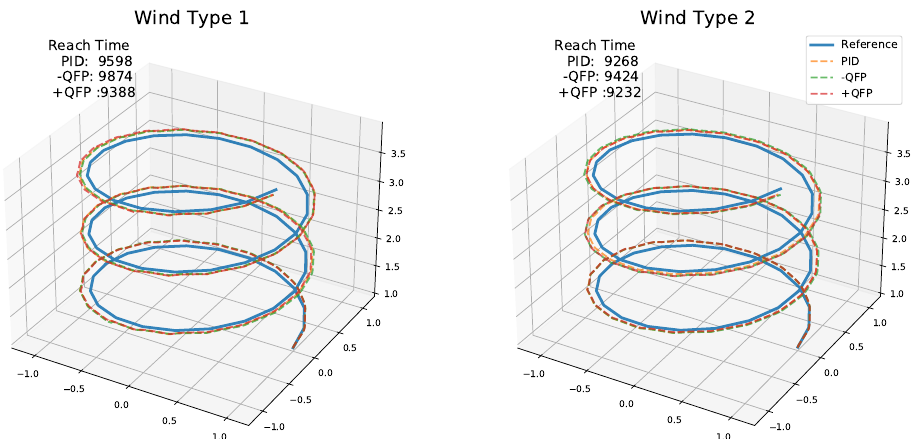
Figure 9. The result trajectory of the quadrotor for models PID, CFA-QFP, and CFA+QFP. Wind type 1 is the circular wind, and wind type 2 is the line wind. The number is the reach time of the last waypoint.